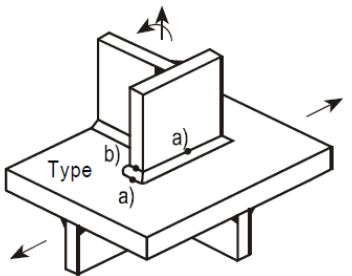
Figure 12 . Two types of hot spot. Figure 12. Two types of hot